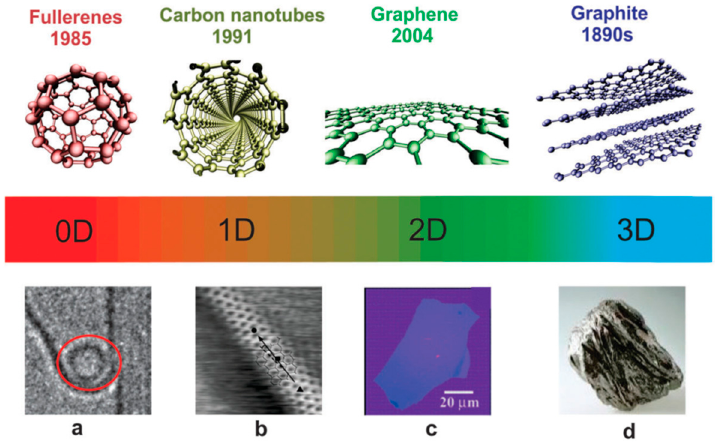
Figure 1. Classification and examples of nanomaterials with 0D, 1D, 2D, and 3D structures: ( a ) fullerene (inside red circle); ( b ) single-walled carbon nanotube; ( c ) multilayer graphene flake, and ( d ) natural graphite. Reprinted with permission [4].